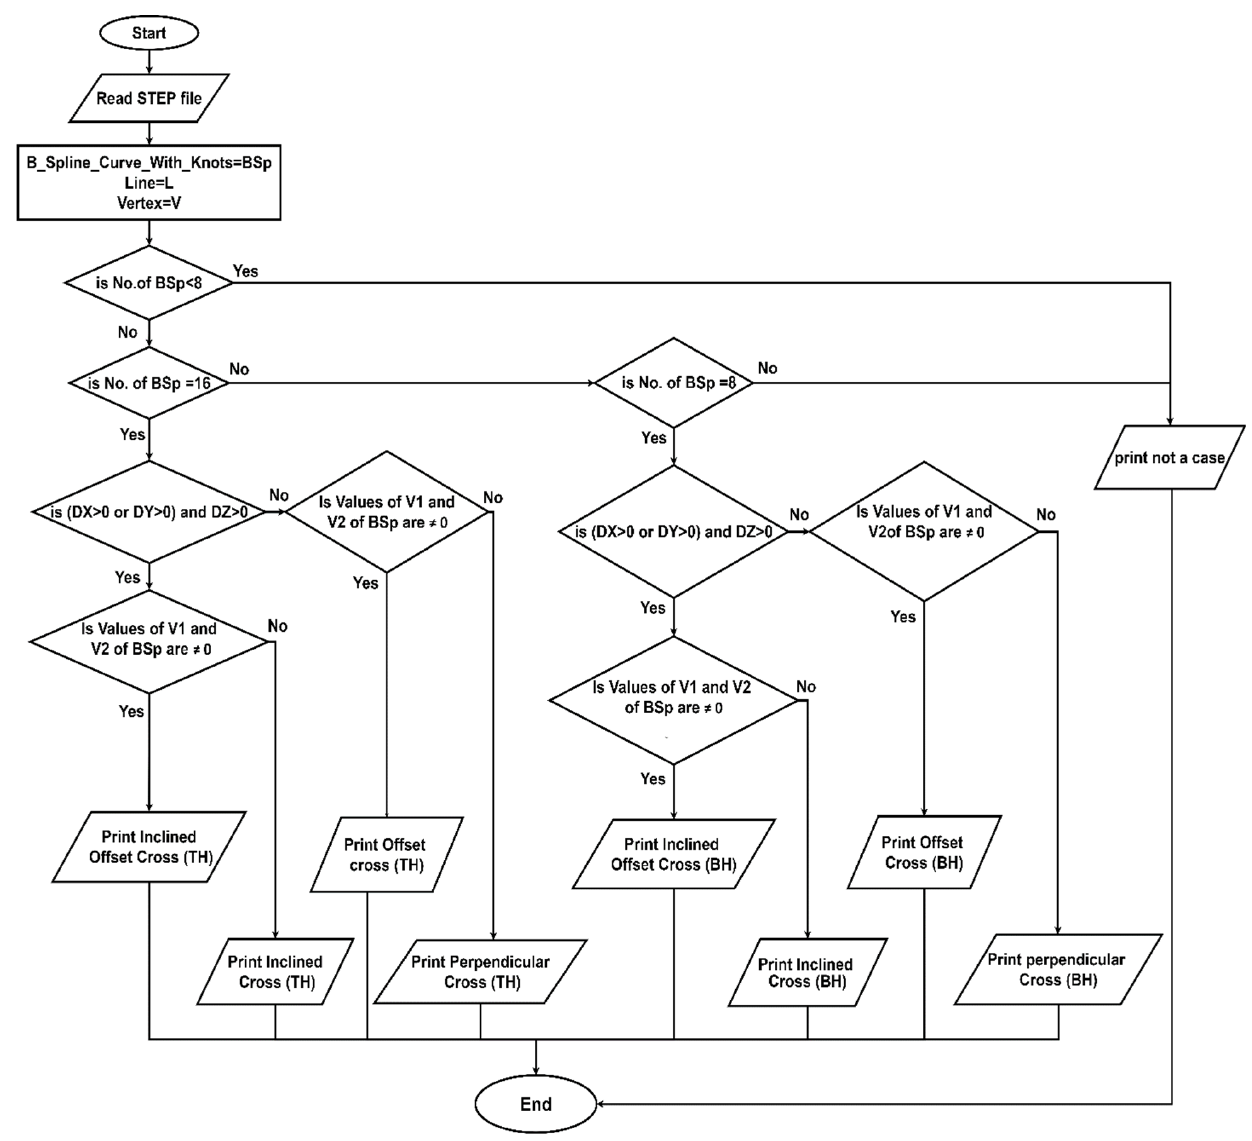
Figure 4. Flowchart of automatic feature recognition of cross-holes in hollow cylinders.